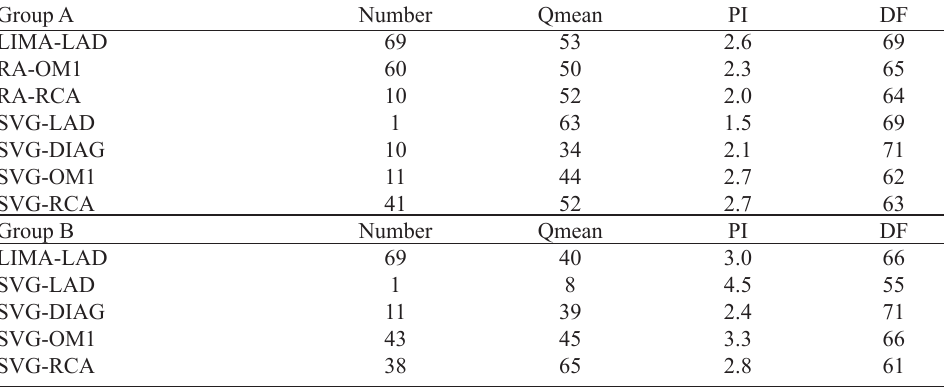
Table 2. Number, mean graft flow, diastolic filling, and pulsatile index values for Group A and Group B